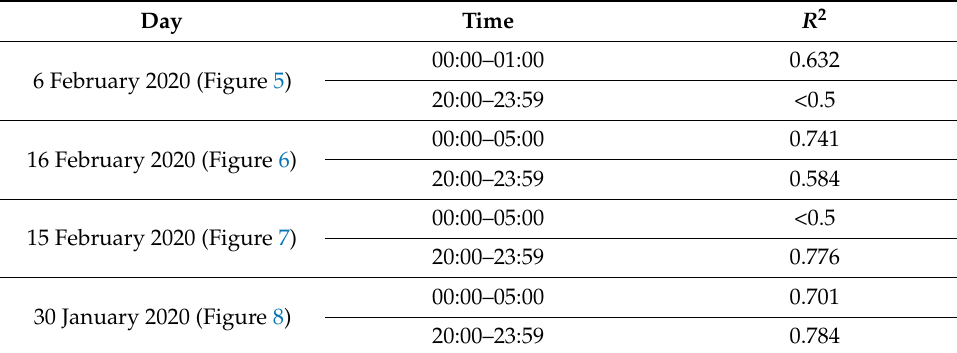
Table 6. R 2 values for several days that were not included in the regression method.